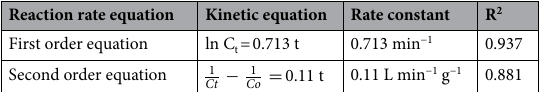
Table 2 clarifies the reaction rate of 1 g/L initial oil concentration, TiO 2 of 1.5 g/L, 850 rpm and H 2 O 2 of 3 mL. The linear form of first- and second order kinetic models can be presented in Eqs. (10, 11).